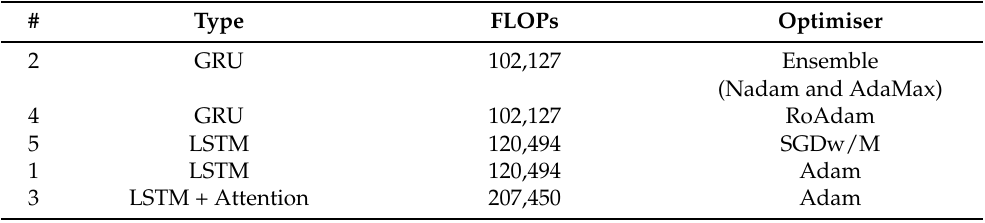
Table 7. A number of floating point operations per second (FLOPs) for each model, with 3 layers and 131 neurons (43 per layer), and hyperparameters. The optimiser column serves as a